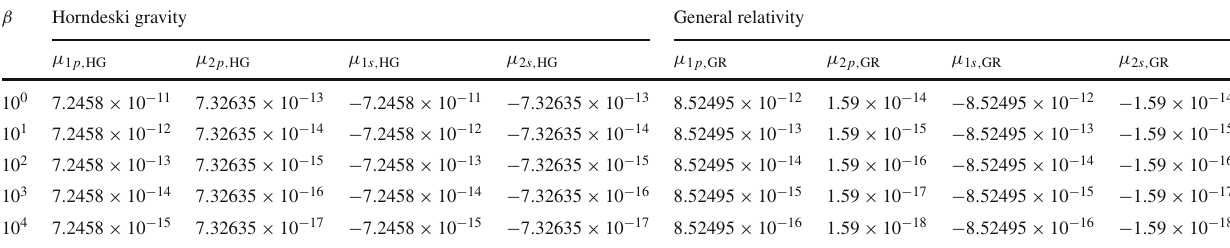
Table 6 Magnifications of first order and second order relativistic images due to lensing by Sgr A* with d = D LS / D OS = 0 . 5: GR and Horndeski Gravity ( q = − 0 . 5 ) predictions for magnifications μ n is given for different values of angular source position 1 p and 1 s refer to first order relativistic images on the same side